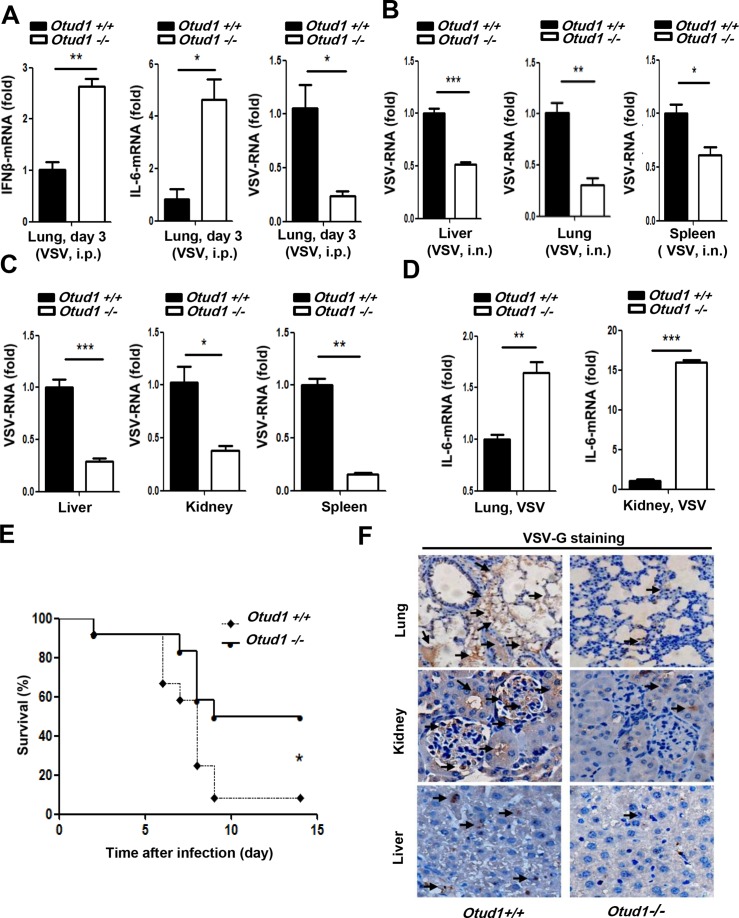
OTUD1 deficiency protects mice from RNA virus infection.(A) Q-PCR analysis of IFNβ (left), IL-6 (middle) and VSV (right) mRNA expression in the lungs of Otud1+/+ or Otud1-/- mice (n = 5 per group) 3 days after intraperitoneal injection with VSV (2X108 pfu per mouse). The data were shown as fold change normalized to that in Otud1+/+ mice. (B) Q-PCR analysis of VSV RNA expression in the liver (left), lung (middle) and spleen (right) of Otud1+/+ or Otud1-/- mice (n = 5 per group) with intranasal infection by VSV (2X107 pfu per mouse) for 3 days. The data were shown as (A). (C) Q-PCR analysis of VSV RNAs expression in the organs of Otud1+/+ or Otud1-/- mice (n = 4 per group) 14 days after intraperitoneal injection with VSV (2X108 pfu per mouse). The data were shown as (A). (D) Q-PCR analysis of IL-6 mRNA expression in the organs of Otud1+/+ or Otud1-/- mice (n = 4 per group) 14 days after intraperitoneal injection with VSV (2X108 pfu per mouse). The data were shown as (A). (E) Survival of Otud1+/+ or Otud1-/- mice (n = 12 per group) given intranasal infection of VSV (2X107 pfu per mouse). *P<0.05. (F) Immunohistochemistry analysis of VSV encoded VSVG protein in the organs from Otud1+/+ or Otud1-/- mice with intranasal VSV (2X107 pfu per mouse) infection for 3 days. *P<0.05, **P<0.01 and ***P<0.001 (unpaired t-test (A-D) or Gehan-Breslow-Wilcoxon test (E)). Error bars represent the mean and s.d. of three independent experiments.